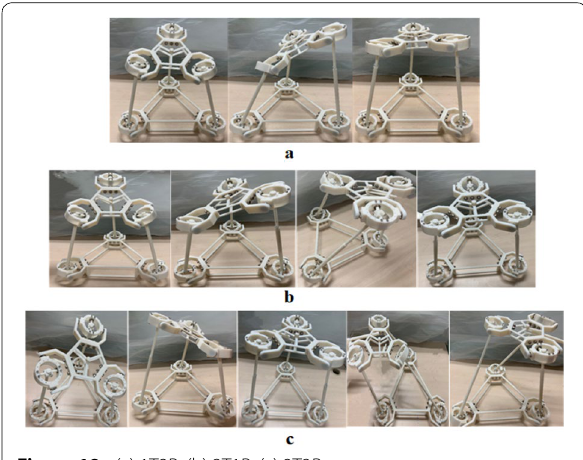
Figure 18. (a) 1T2R, (b) 3T1R, (c) 2T3R